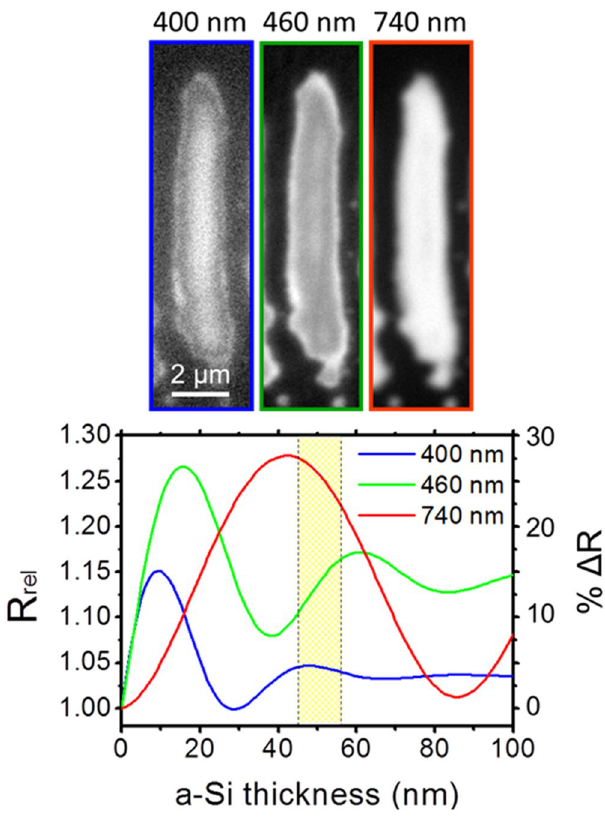
Figure 5. Optical study of a single long-period amorphous fringe ( Λ s + LIPSS) for thickness determination. Top row: Optical micrographs of the same fringe recorded upon illumination at different light wavelengths (see labels). Bottom graph: Calculated reflectivity change as a function of thickness of an amorphous top layer for the three illumination wavelength employed, using the model described in the text. The shaded area corresponds to the interval for the maximum thickness, determined from a comparison of reflectivity data and calculation.